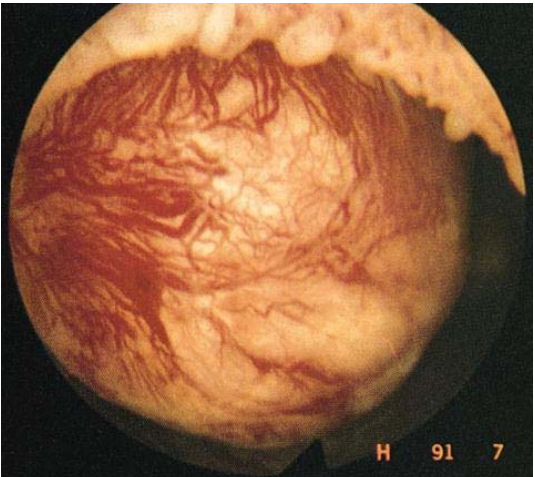
Figure 3. Enhanced vascularization with the presence of dilated blood vessels on the myoma surface, visible by hysteroscopy.